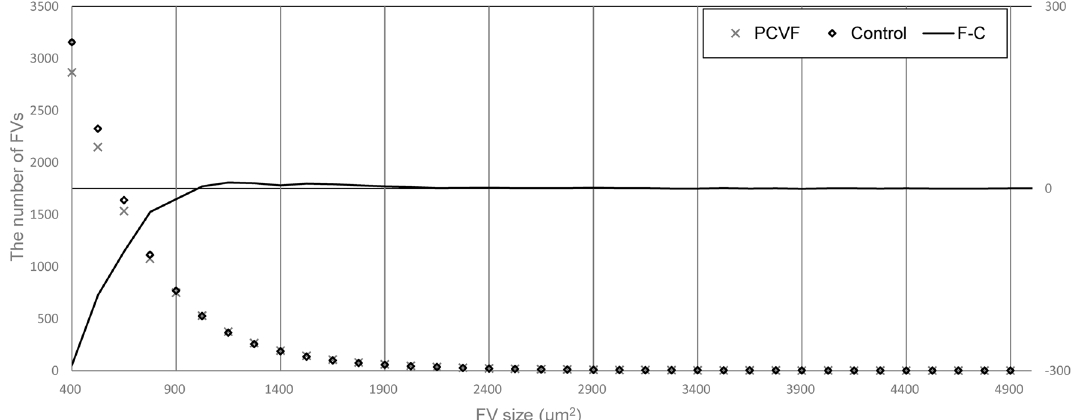
Figure 6. Demonstration of the FV distribution in a fellow eye of PCV with CVH and a control eye. The plot shows the typical power-law distribution of FV. The small sizes had relatively large numbers. The line shows the difference between the two eyes. Our strategy focused on a specific range, which avoids statistical biases due to the large disparity in numbers. PCVF PCV fellow eyes, Control age-matched control group, F–C difference between the PCVF and control